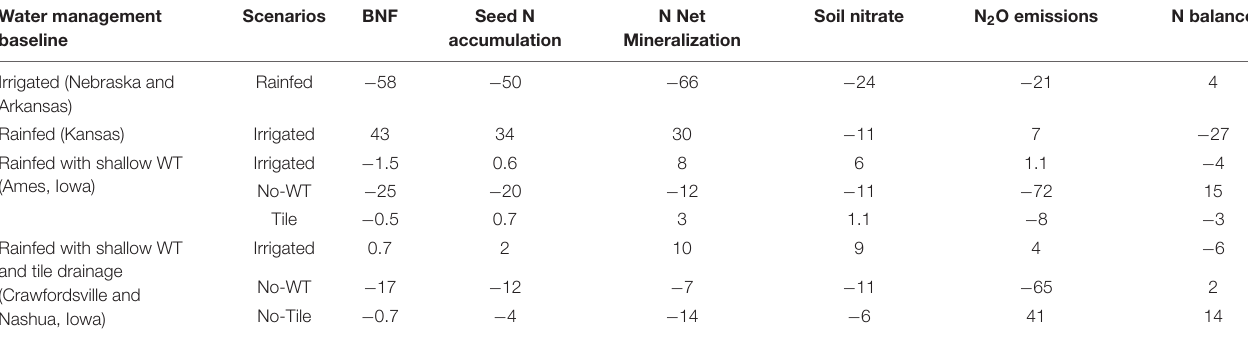
TABLE 2 | Simulated impacts of water management on N fluxes (% changes in relation to baseline